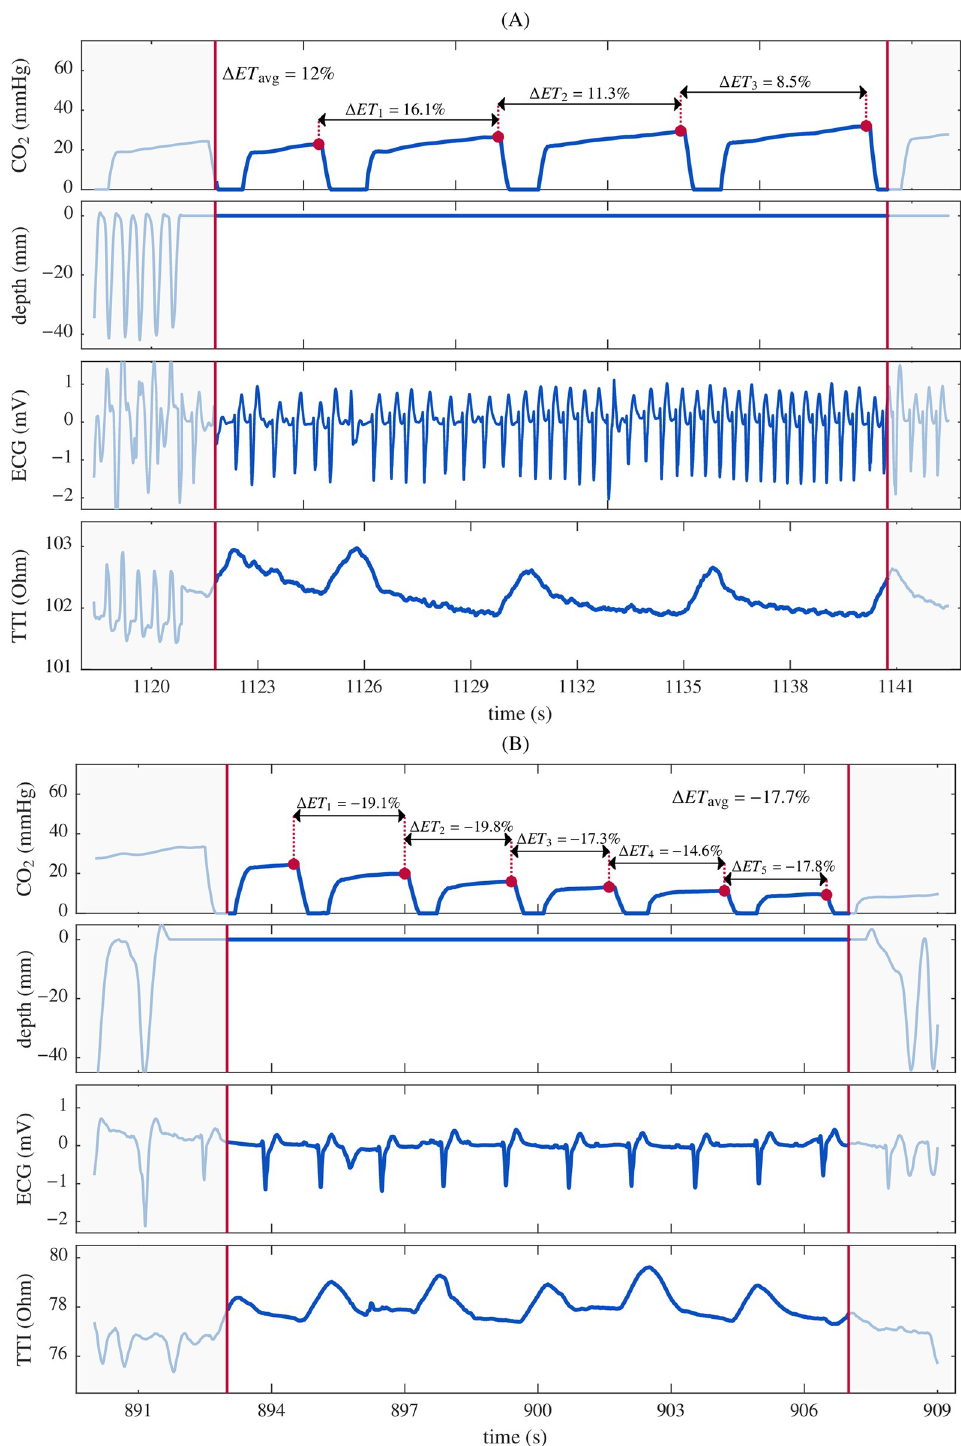
Fig 1. Examples of segment annotation. (A) ROSC segment and (B) non-ROSC (PEA) segment. Capnogram, compression depth, ECG and transthoracic impedance (TTI) signals are depicted for each segment.